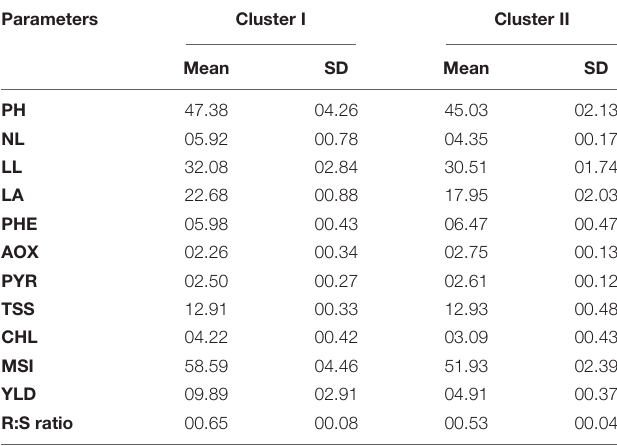
TABLE 9 | Descriptive statistics for various parameters of 12 contrasting genotypes under different clusters. Parameters